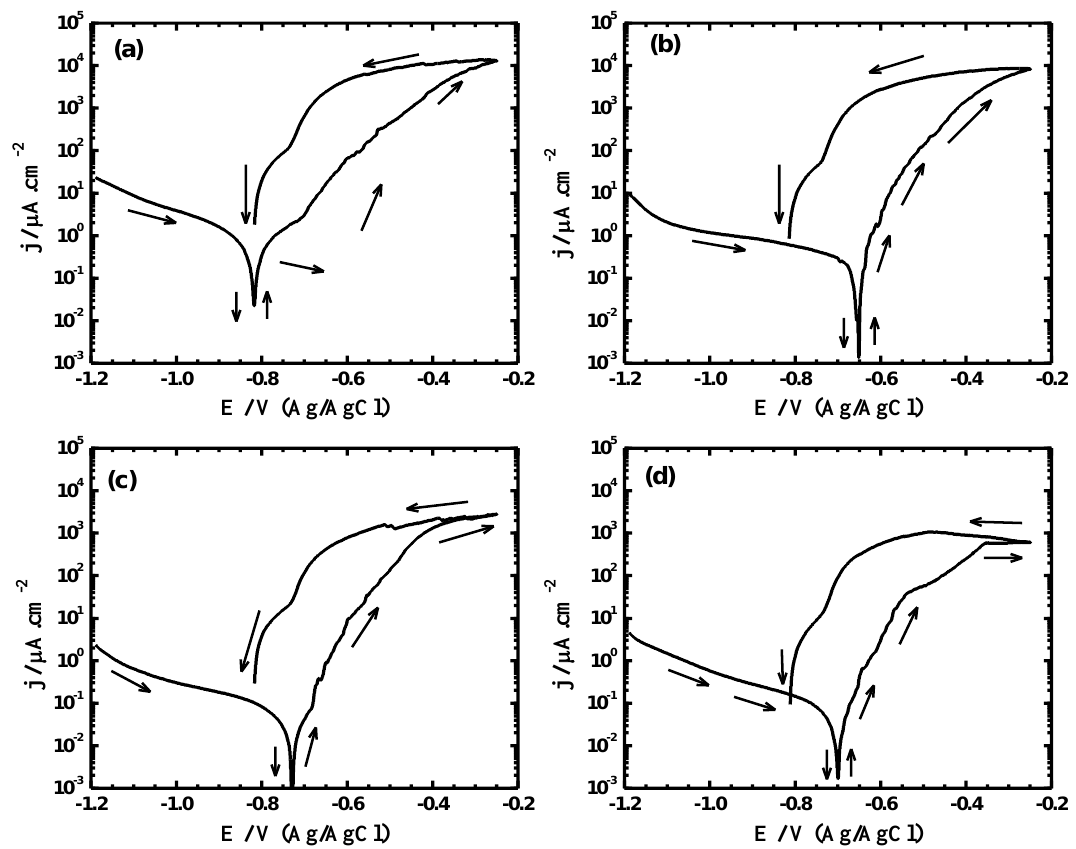
Figure 2. Cyclic potentiodynamic polarization (CPP) curves for AA 6061 alloys, ( a ) the as received and the extruded alloys at ( b ) 350, ( c ) 425, and ( d ) 500 °C, respectively after 24 h immersion in 3.5% NaCl solutions.